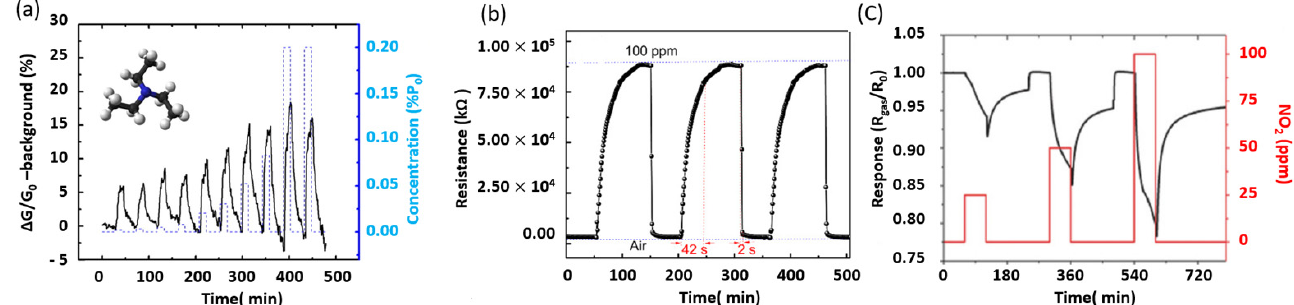
Figure 9. ( a ) MoS 2 sensor response exposed to TEA (adapted from Ref. [147] Copyright 2013, American Chemical Society); ( b ) repeatability and reversibility of the FLMN gas sensor at 100 ppm NO 2 concentration (reproduced and adapted from Ref. [168], Copyright 2019, MDPI); and ( c ) the MoS 2 /CNT sensor response as a function of three NO 2 concentrations (25, 50, and 100 ppm) (reproduced and adapted from Ref. [42], Copyright 2017, Wiley-VCH).